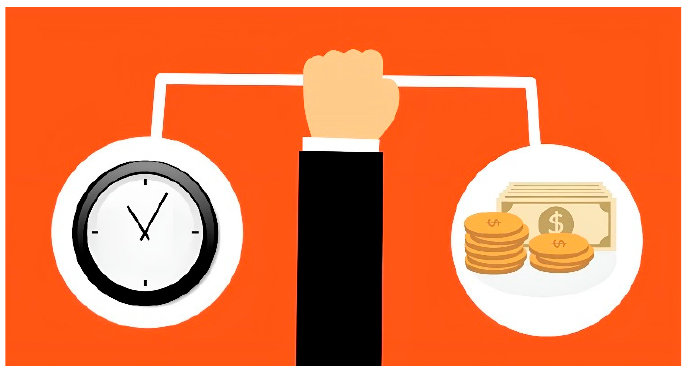
Figure 4. Visual metaphor of the “time value of money” concept. Source: www.magnimetrics.com Available online: https://bit.ly/3J2CQoj (archived on 8 March 2023).